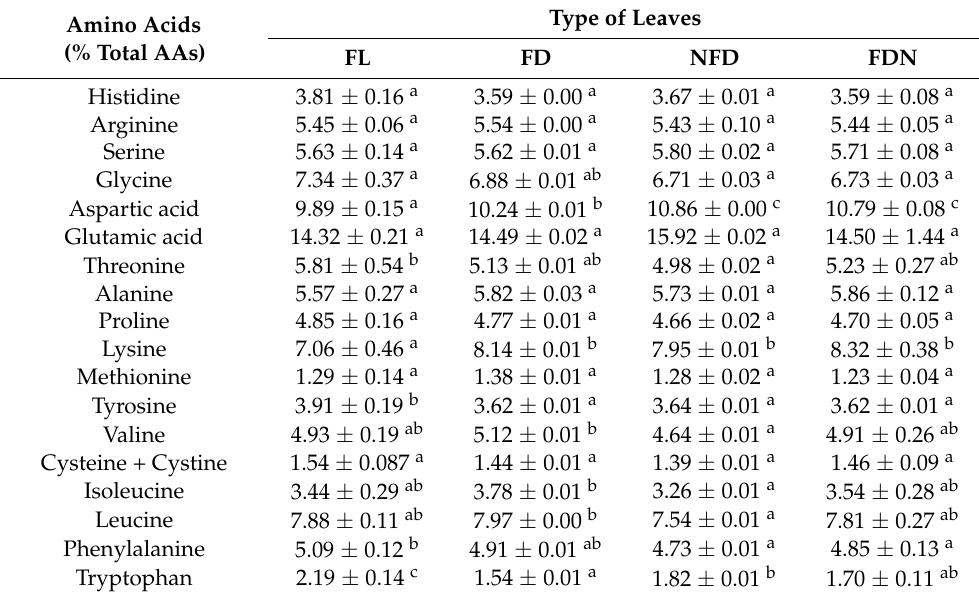
Table 2. Amino acid profile of